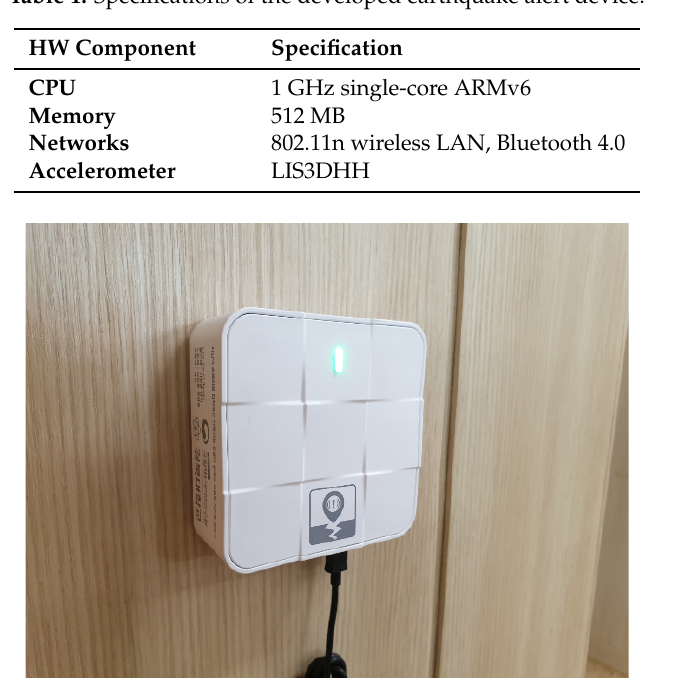
Table 1. Specifications of the developed earthquake alert device.